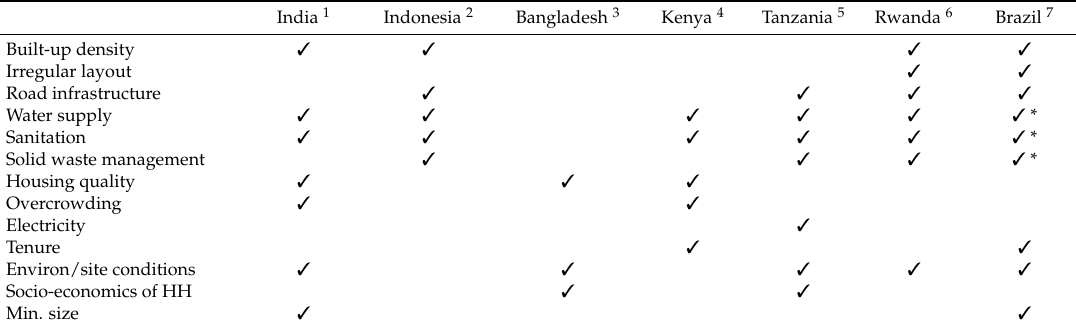
Table 2. National slum definitions found in relation to the national